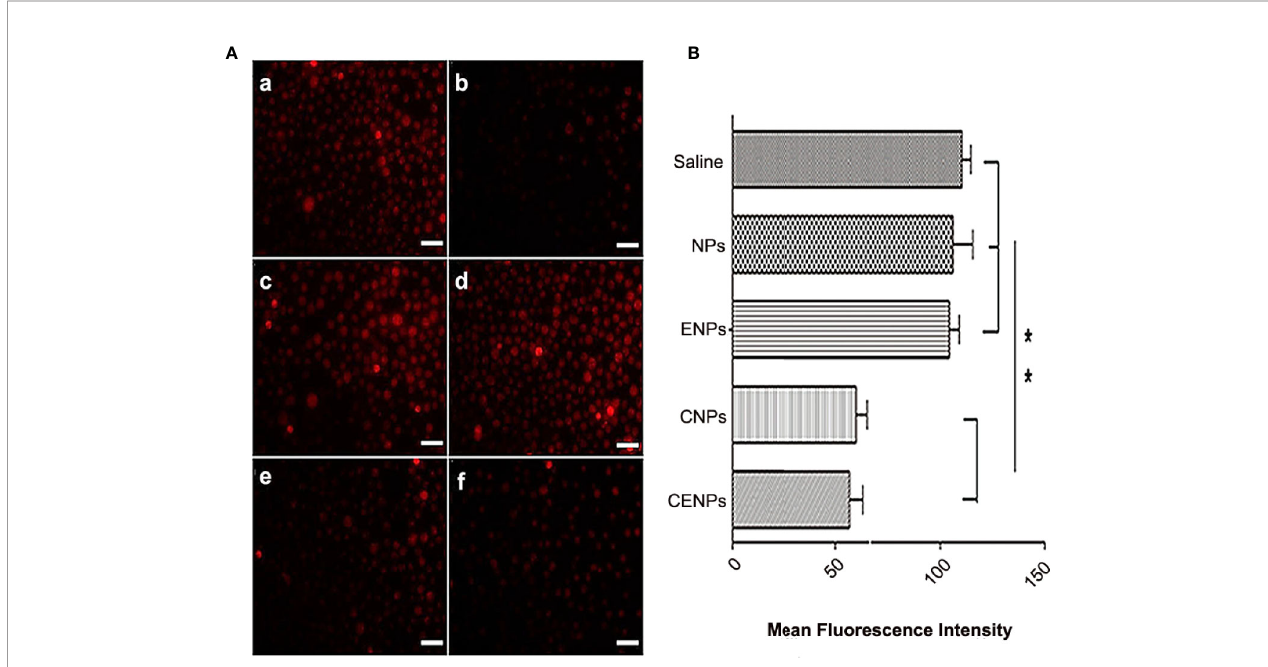
FIGURE 4 | Enhanced H 2 O 2 decomposition and O 2 generation in CA46 cells after incubation of nanoparticles. (A) Level of intracellular ROS after incubation of nanoparticles. a. Control; b. NAC pre-treated; c. NPs; d. ENPs; e. CNPs; f. CENPs. (B) Flowcytometry data of CA46 cells stained with O 2 indicator [Ru(dpp) 3 ]Cl 2 after different treatments were analyzed. Data are expressed as the mean ± SD (n = 3); **p < 0.01. (scale bars 100 m